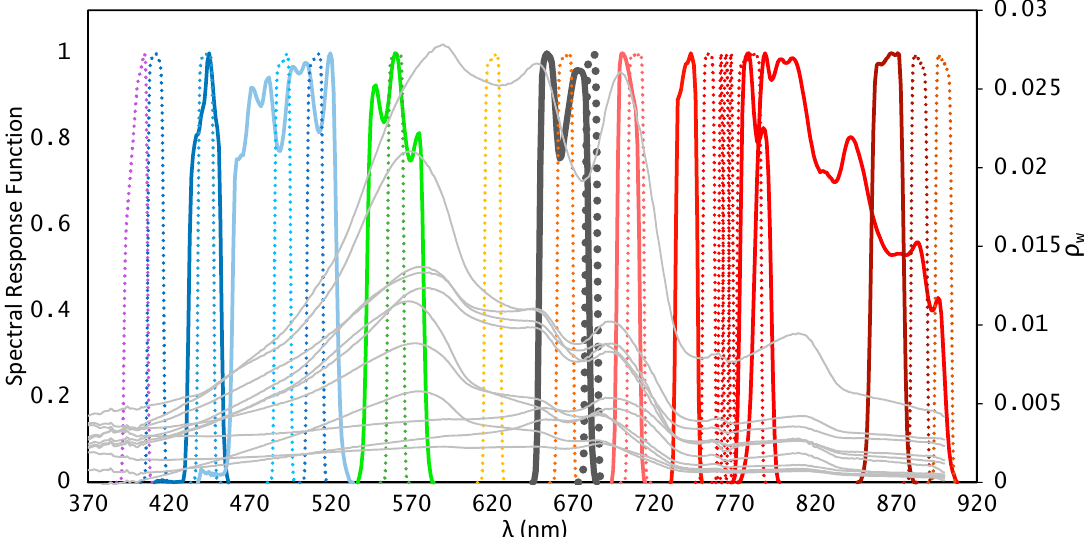
Figure 2. Comparison of MultiSpectral Instrument (MSI) (solid lines) and Ocean Color and Land Imager (OLCI) (dotted lines) bands at specific wavelengths considering Spectral Response Function over visible and near-infrared (NIR) part of the spectrum. Bands at second chl a absorption peak are highlighted by bold grey lines. Grey thin solid lines show the variation of in situ measured ϱ w spectrums.